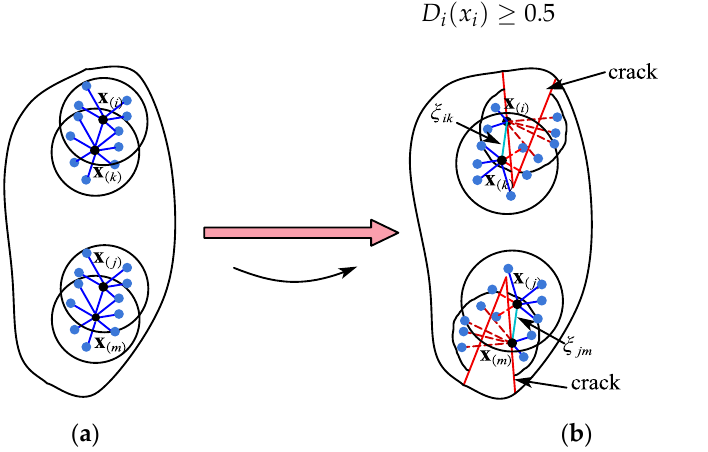
Figure 9. Transition from tooth root fatigue crack nucleation to propagation. ( a ) Nucleation of fatigue crack. ( b ) Propagation of fatigue crack.